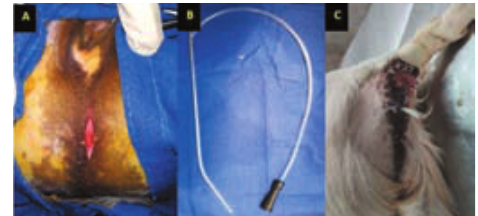
Fig-1 . Modified Perineal Urethrostomy) using direct guided urethral catheterisation technique